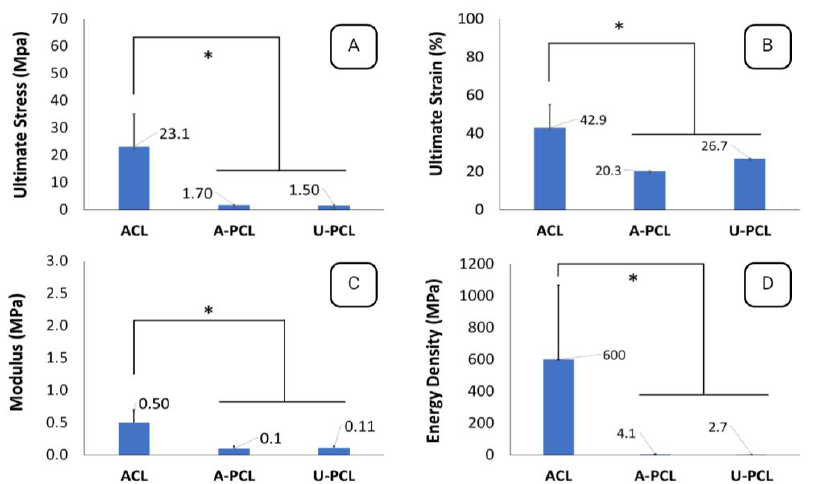
Figure 8. Comparison of ACL and electrospun constructs in terms of mechanical properties. ( A ) Ultimate Stress, ( B ) Ultimate Strain, ( C ) Modulus, and ( D ) Energy Density graphs determined at 5mm/min. * displays significant difference at p < 0.05. A-PCL, aligned PCL; U-PCL, unaligned PCL.